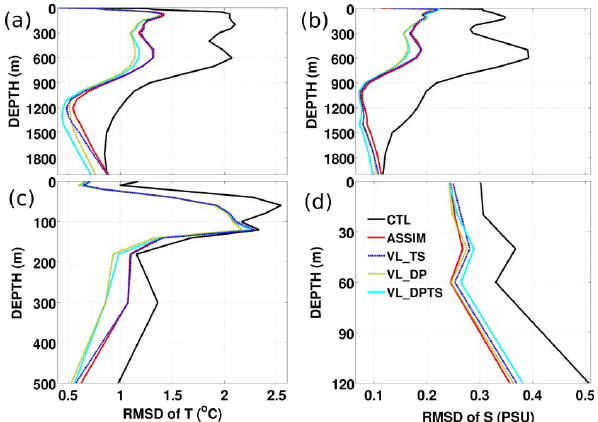
Figure 10. Vertical distribution of the RMSD of temperature ( ◦ C) and salinity (psu) against 47999 Argo profilers and 16 PIRATA fixed moorings in the model domain (100 ◦ W–20 ◦ E, 78 ◦ S–50 ◦ N) from 1 January 2010 to 31 December 2012 according to the con- trol run (black) and the prior state of the experiment ASSIM (red), VL_TS (dark dashed blue), VL_DP (dark dashed yellow) and VL_DPTS (light blue). (a) and (b) correspond to the RMSD of T and S with respect to Argo observations while (c) and (d) cor- respond to the RMSD of T and S with respect to PIRATA data,